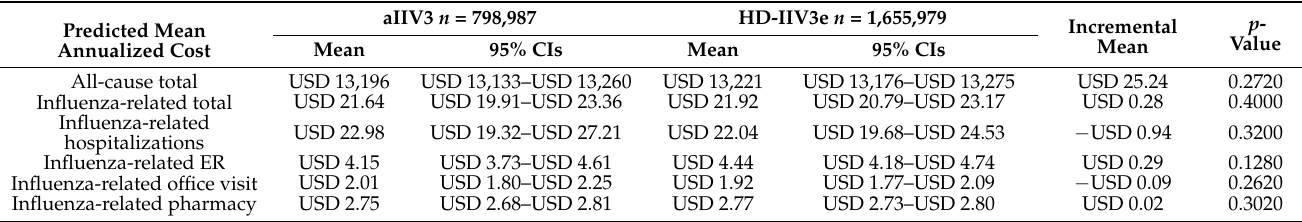
Table 3. Economic Outcomes—Predicted Mean Annualized Costs Obtained using Recycled Predictions—Post IPTW and GLM